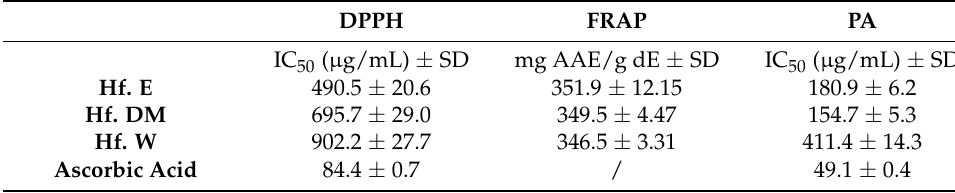
Table 4. Hypericum foliosum extracts’ antioxidant activity.